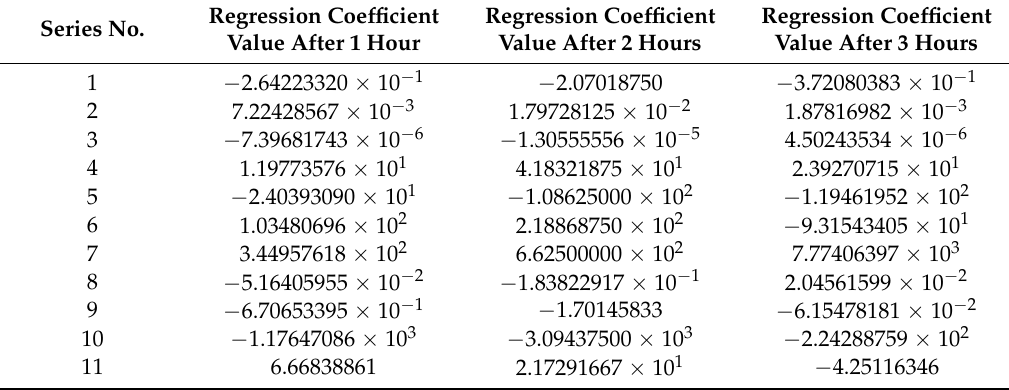
Table 6. Values of regression coefficients after one, two, and three hours of the charging process. Series